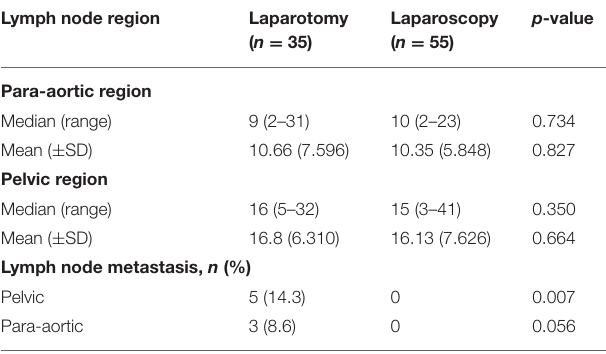
TABLE 2 | Number of lymph nodes harvested through systemic lymphadenectomy and prevalence of lymph node metastasis by surgical